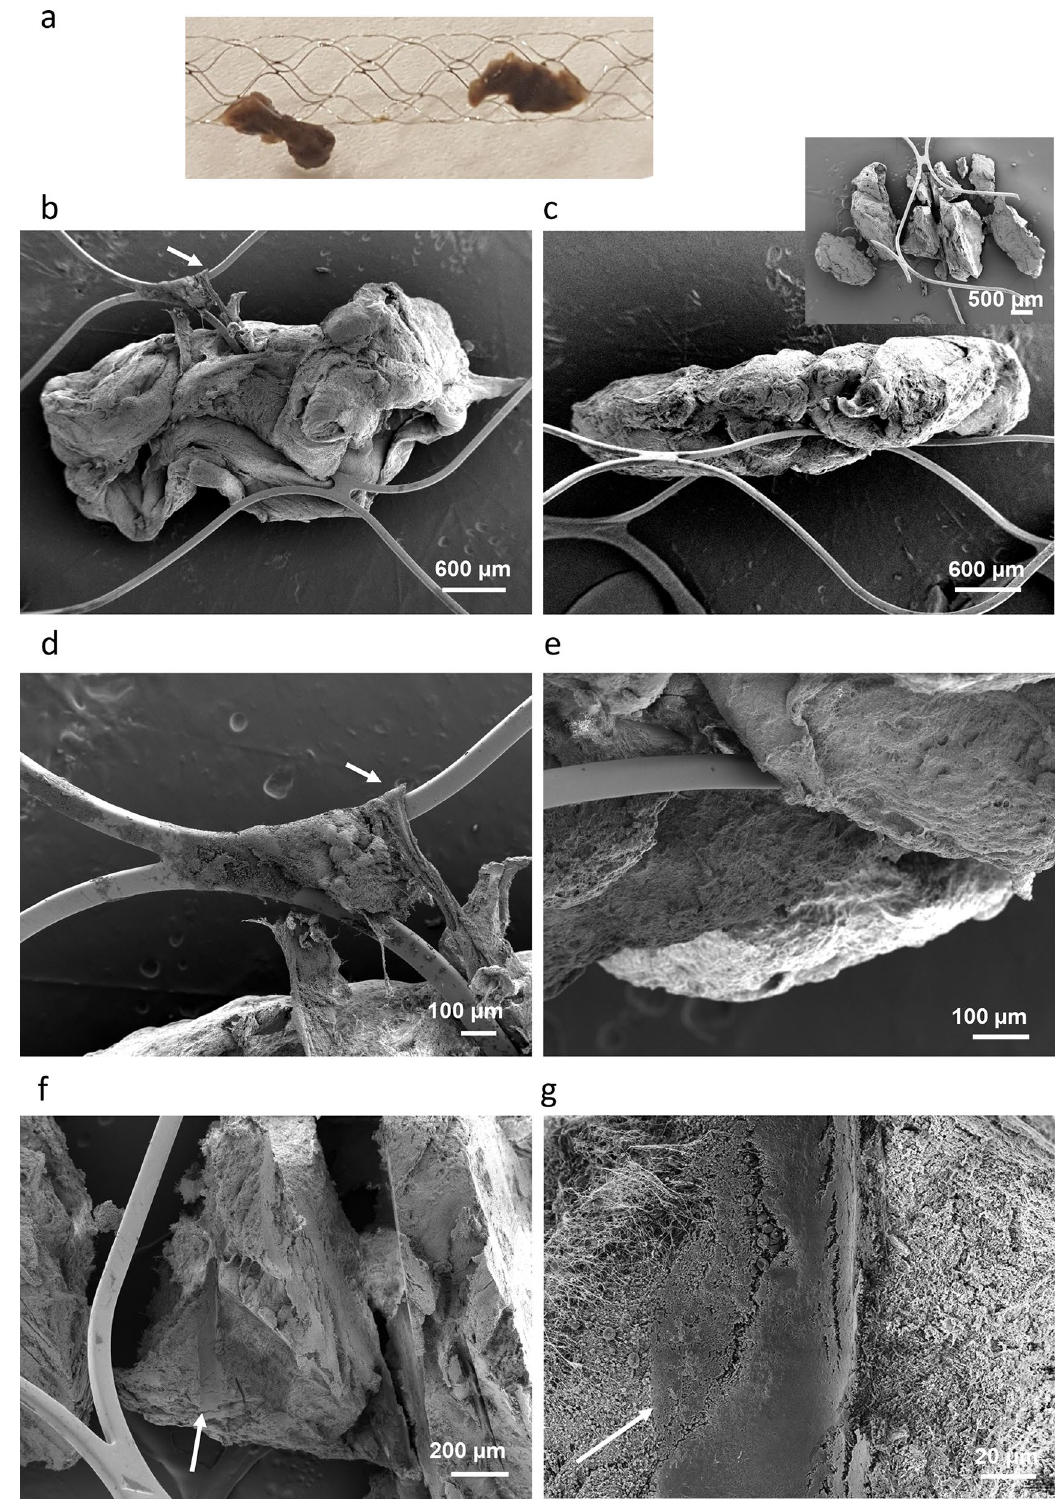
Figure 3. Intermediate thrombus incorporated into the stent retriever (Case 4 in Table 1). ( a ) Optical micrograph. ( b , c ) SEM view of thrombus on stent. Insert in ( c ) View of sectioned thrombus and the stent struts at the anchoring site. ( d ) Fibrin strings wetting the stent surface (indicated by arrows in a , d ). ( e ) Thrombus clutches onto the stent struts. ( f ) Section through the compact thrombus, showing the contact region with the stent strut (indicated by arrow). ( g ) Higher magnification view of the thrombus surface at the contact with the stent (indicated by